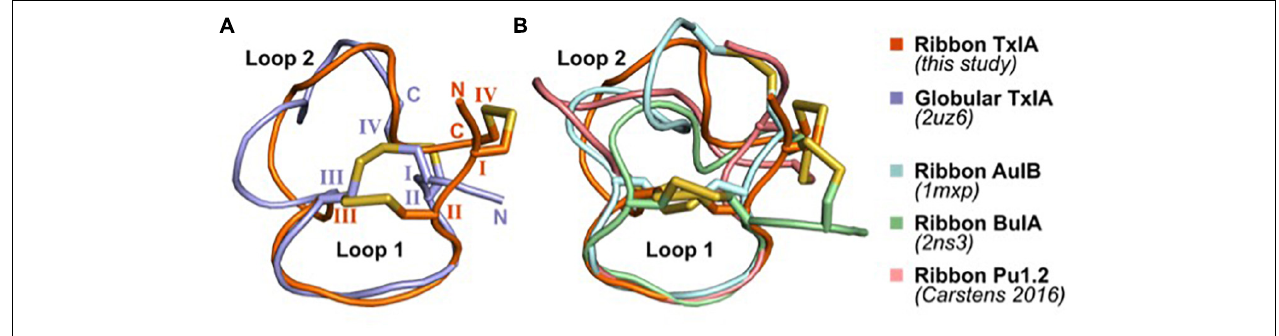
FIGURE 6 | Comparison of the NMR solution structure of ribbon TxIA with (A) globular TxIA and (B) other ribbon contoxin structures. The first model from the NMR ensemble was used in this figure, with the caveat that the 20 models of ribbon AuIB display a high conformational variability of Loop 2. The peptides are shown in cartoon representations and the disulfide bonds are indicated as yellow sticks. The N- and C-termini are indicated in (A) , and the hemi-cystine residues are numbered using Roman numerals. The PDB identifier of the experimentally determined three-dimensional structures is indicated where available.